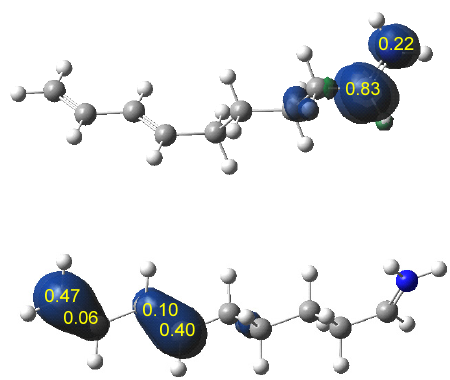
Figure 3. 3D representations of the Mulliken atomic spin densities of the neutral radical and radical cation of the reduced model dieniminium 16e and the electrophilic P +